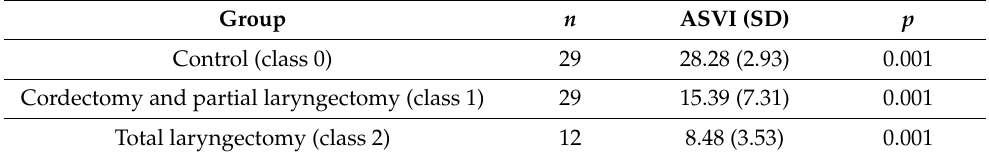
Table 4. The mean acoustic substitution voicing index (ASVI) scores in control and patients’ groups.